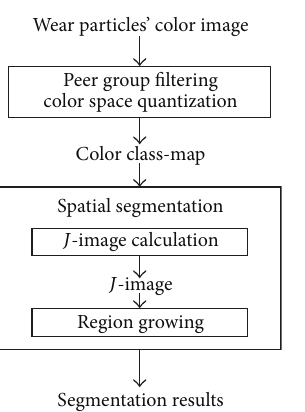
Figure 3: Schematic of the JSEG algorithm for particles’